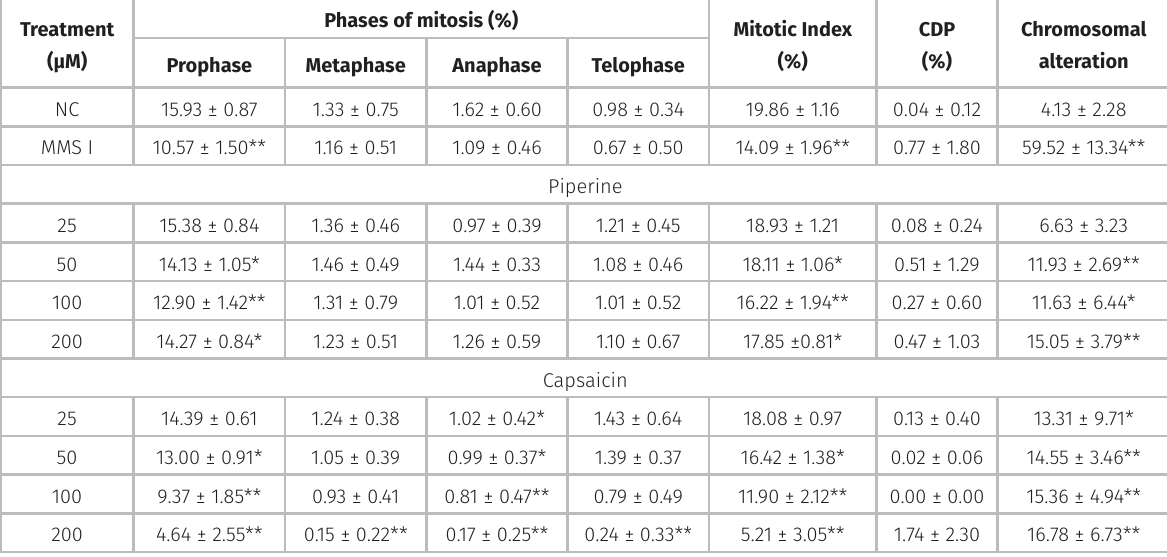
Table I. Phases of mitosis, mitotic index, cells in death process (CDP) and total chromosomal alterations in meristematic cells of A. cepa exposed to different concentrations of piperine or capsaicin.